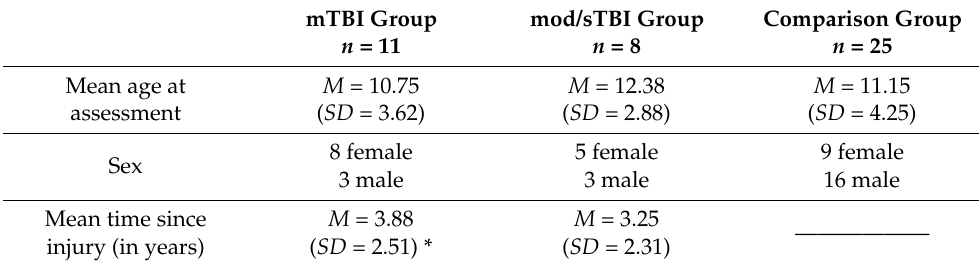
Table 1. Demographic characteristics of participants.